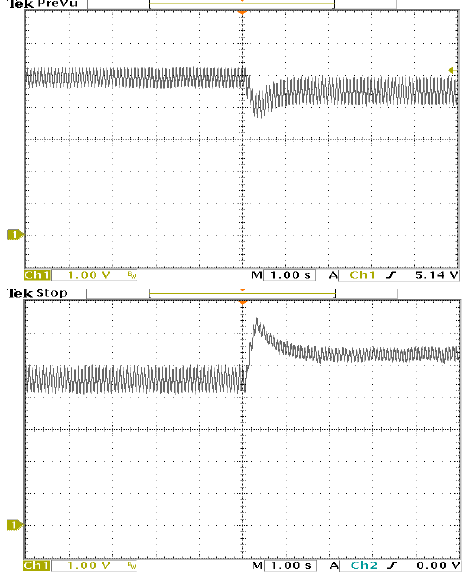
Figure 6. Diesel’s frequency response under load stp change 6  12 kW and 12  0 kW.